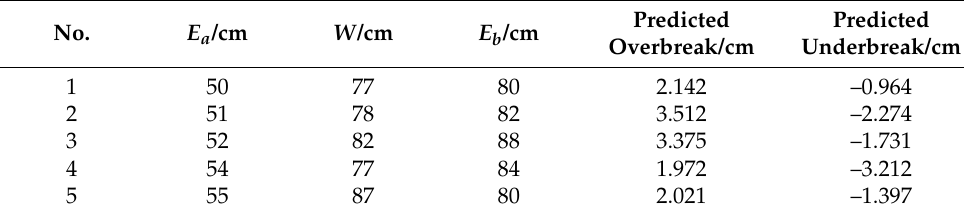
Table 6. Ranges of the parameters to be optimized.